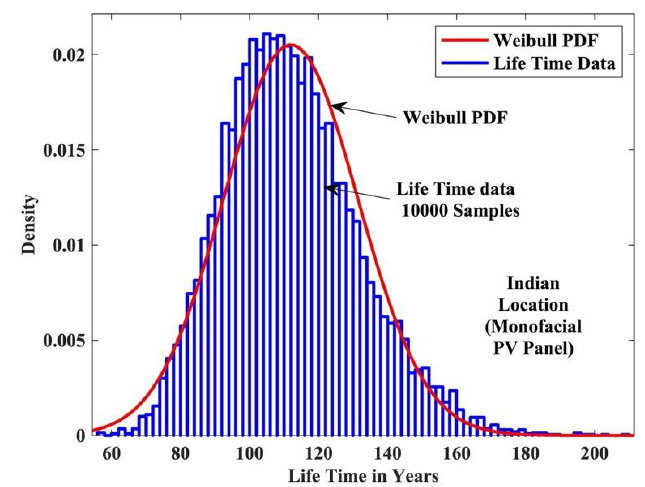
Figure 11. Lifetime distribution of PV inverter at location in India.